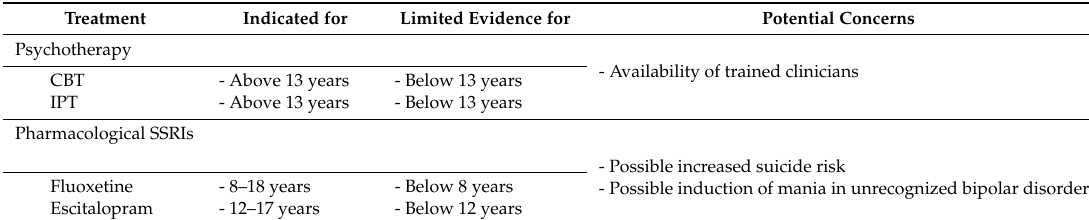
Table 2. Treatments for Pediatric MDD. The two main categories of therapeutic approaches for pediatric MDD treatment are psychotherapy (CBT and IPT) and psychopharmacology (SSRIs: Fluoxetine and Escitalopram). These treatments are indicated for different age ranges, with potential concerns for the SSRIs. MDD: Major Depressive Disorder; CBT: cognitive behavioral therapy; IPT: Interpersonal Therapy; SSRI: selective serotonin reuptake